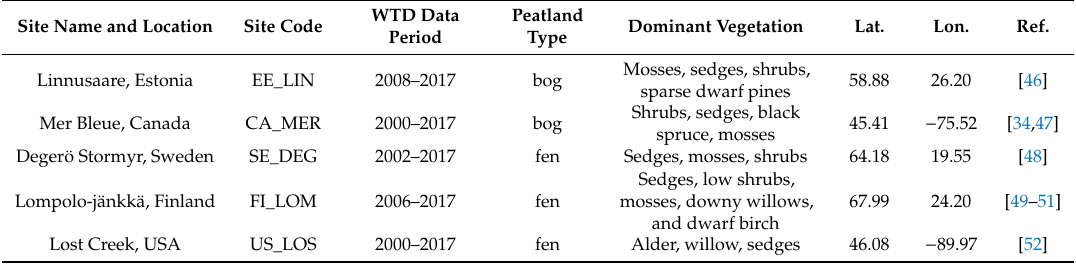
Figure 2. Study sites (red dots) and distribution of northern peatlands (based on Xu et al. [45]). The abbreviations of peatlands are given in Table 1. Table 1. Overview of peatland